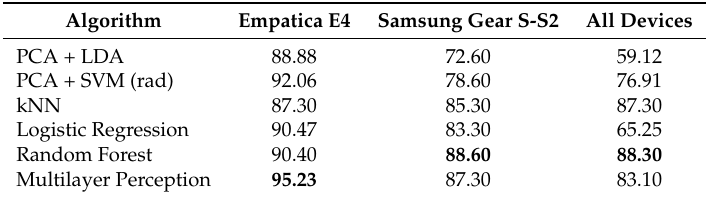
Table 7. Effect of the used device to three-class stress with context classification accuracy when heart activity and accelerometer data are used together.